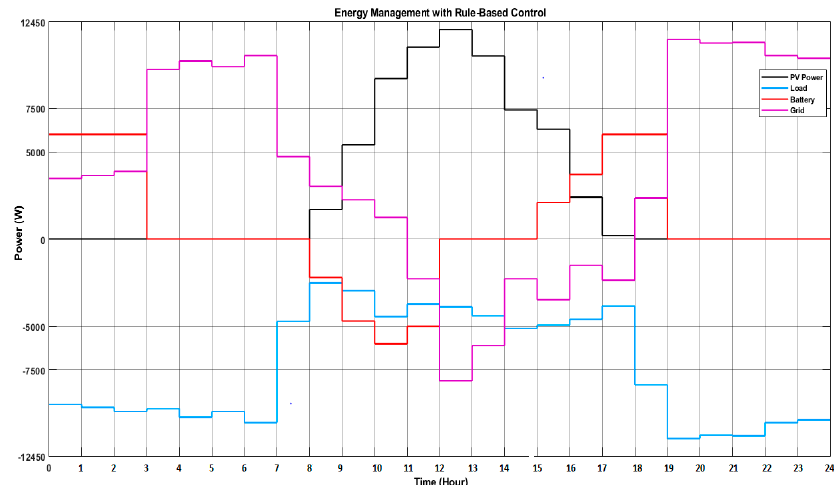
Figure 14. Power dispatching using energy management with rule-based controller (RBC) for Figure14. Powerdispatchingusingenergymanagementwithrule-basedcontroller(RBC)for04 / 02 / 2019. 04/02/2019.